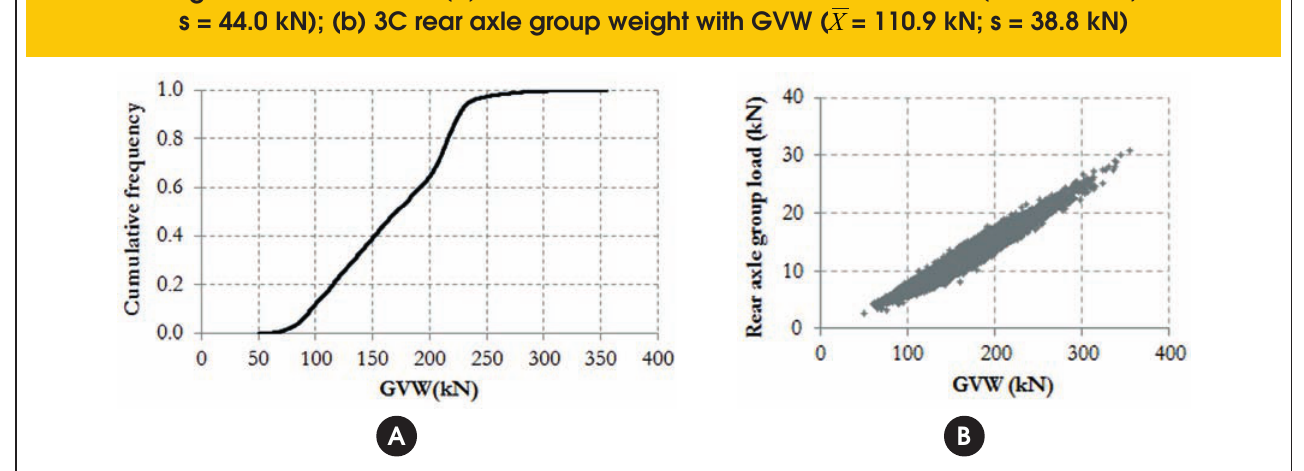
Figure 3 – Variation of: (a) GVW cumulative distribution for class 3C ( = 154.3 kN;